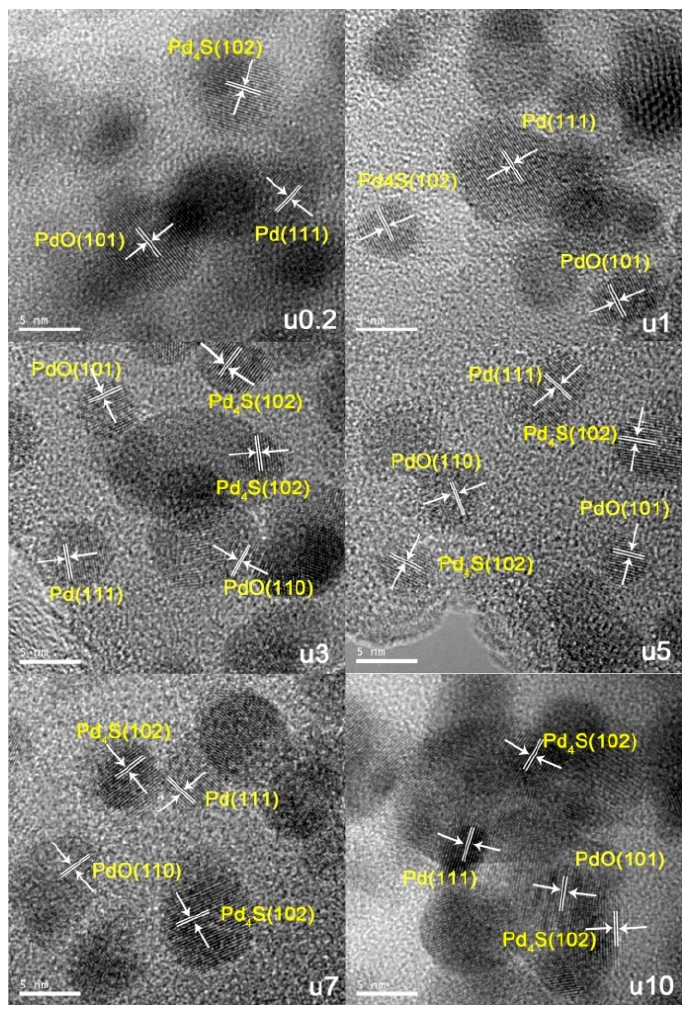
Figure 6. HR-TEM images of the used catalysts with different H 2 S concentration. Table 3 Palladium species content of used catalysts with different H 2 S concentration. a.